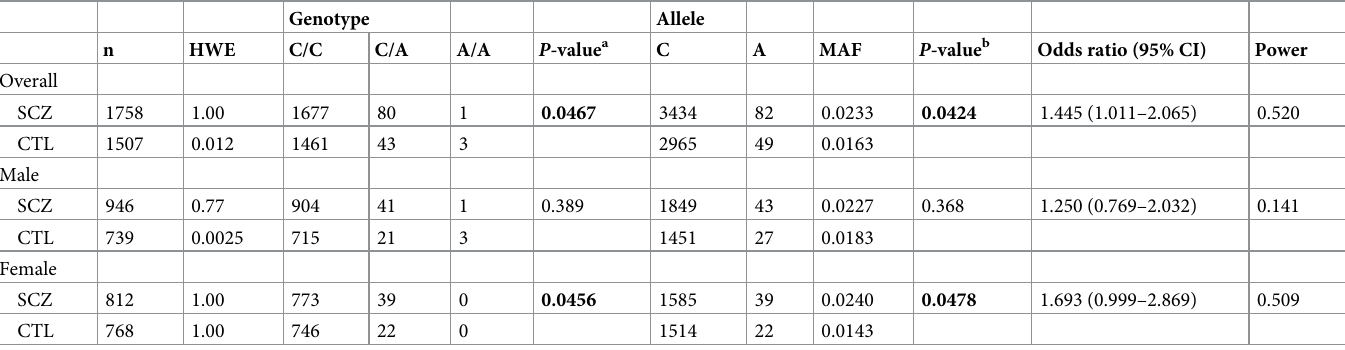
Table 1. Distribution of rs17004038 in patients with schizophrenia and controls in this study.